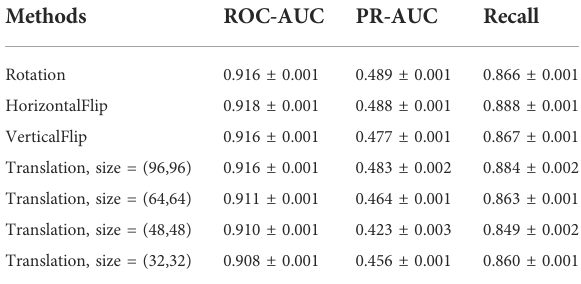
FIGURE 6 Different methods of handling compound images.